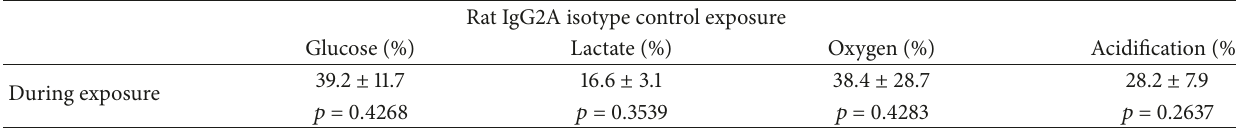
Table8:Metaboliceffectsof25 𝜇 g/mLRatIgG2AIsotypeControlexposureonmacrophages.MeanpeakMAMPheightchangesandstandard errorsforeachexperimentalconditionduringexposureandrecoveryareshown.All 𝑝 valuesarecalculatedbasedonpeakheightversus10 min average basal value prior to exposure.